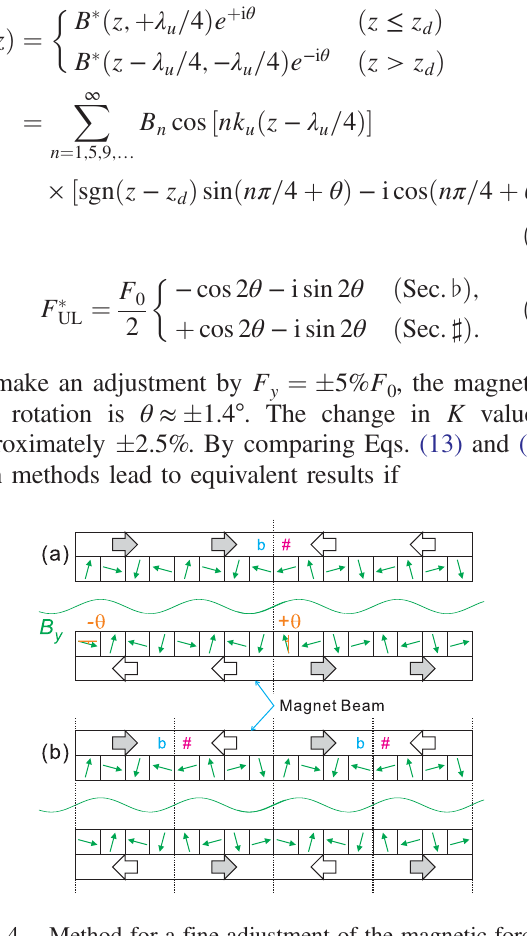
by the easy axis u